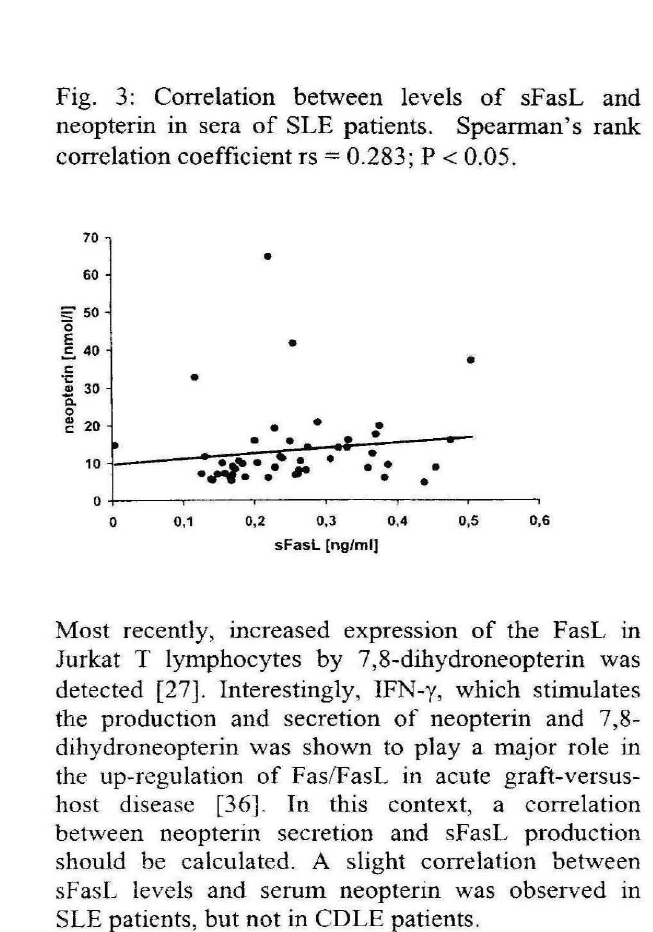
Fig. 3: Correlation between levels of sFasL and neopterin in sera of SLE patients. Spearman's rank correlation coefficient rs = 0.283; P <